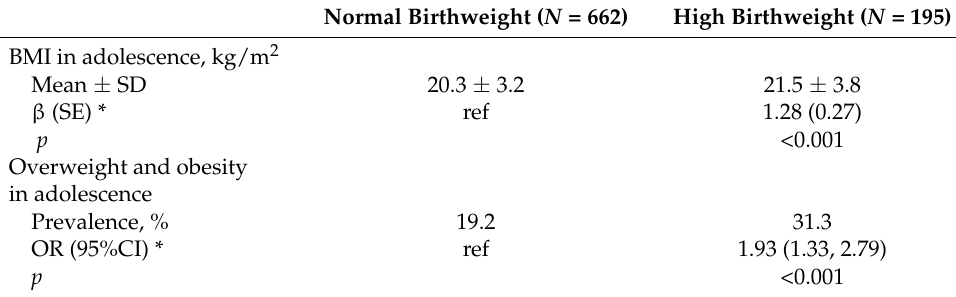
Table 2. Birthweight in relation to weight status in